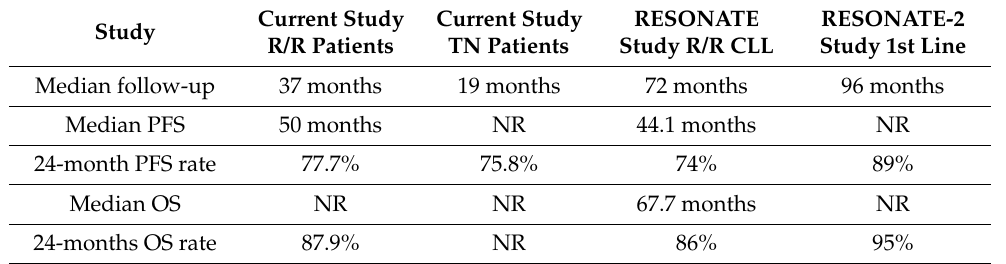
Table 4. Comparison with pivotal clinical trials.